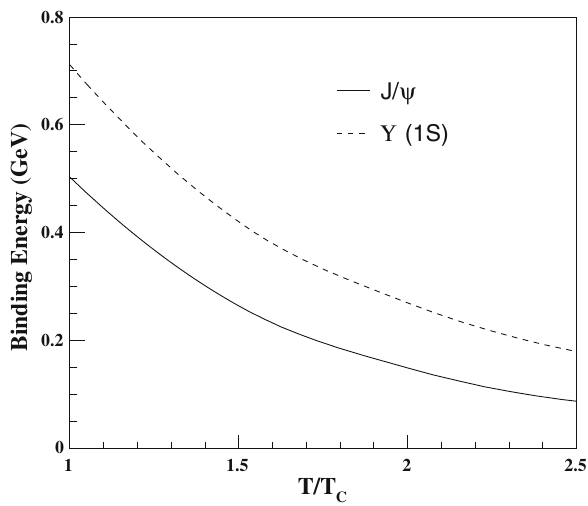
Fig. 14 Variation of decay width ( (cid:8) ) with respect to T / T C . Solid and dashed curves represent the decay width of ϒ( 1 S ) and ϒ( 2 S ) , respec-